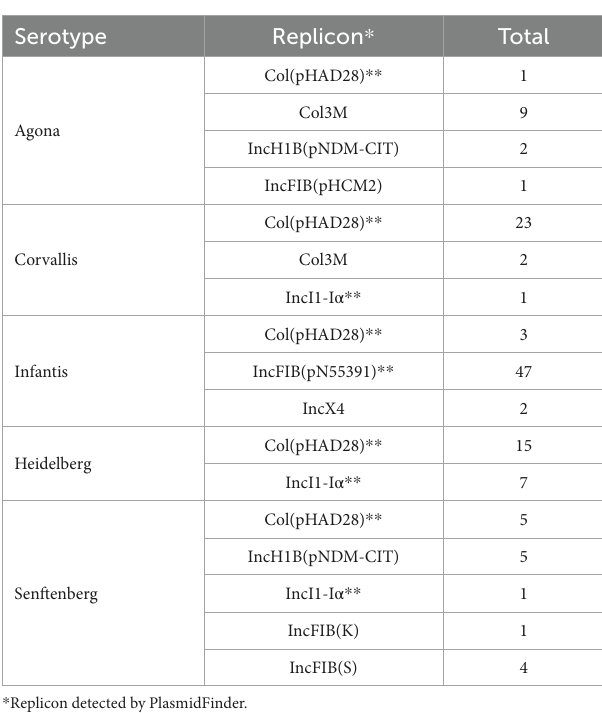
TABLE 2 Prediction of the presence of replicons from plasmids in Salmonella isolates.